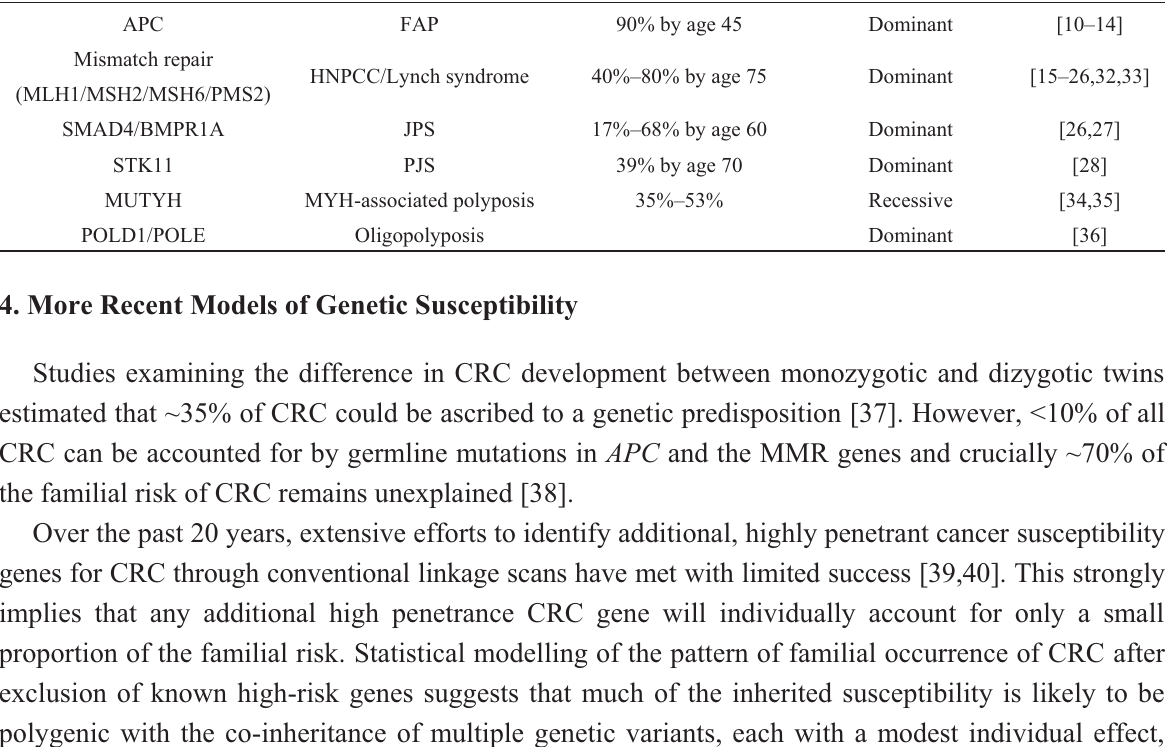
Table 1. Colorectal cancer predisposition syndromes and associated high-penetrance mutations. Gene(s)